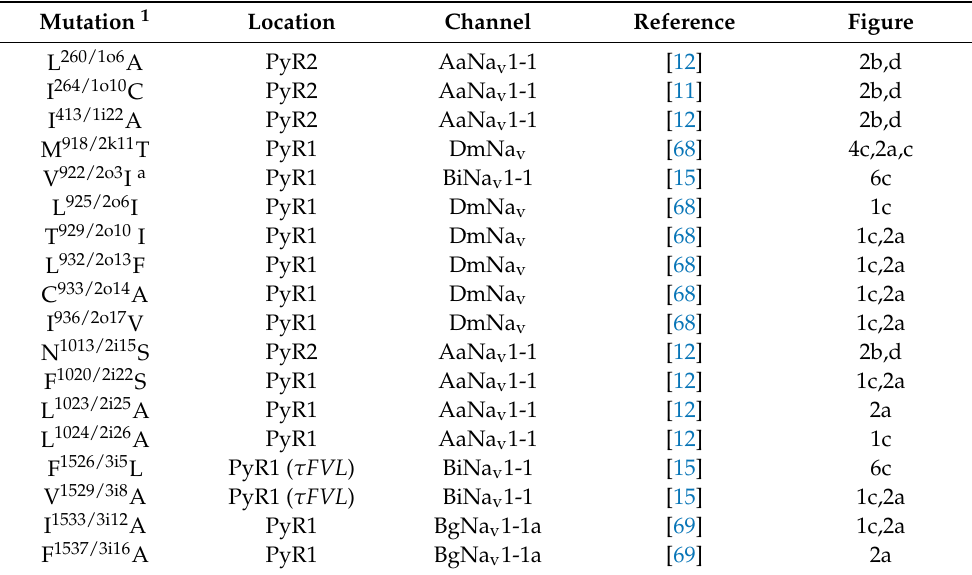
Table 2. Engineered mutations within PyR2 and PyR1 that affect the action of